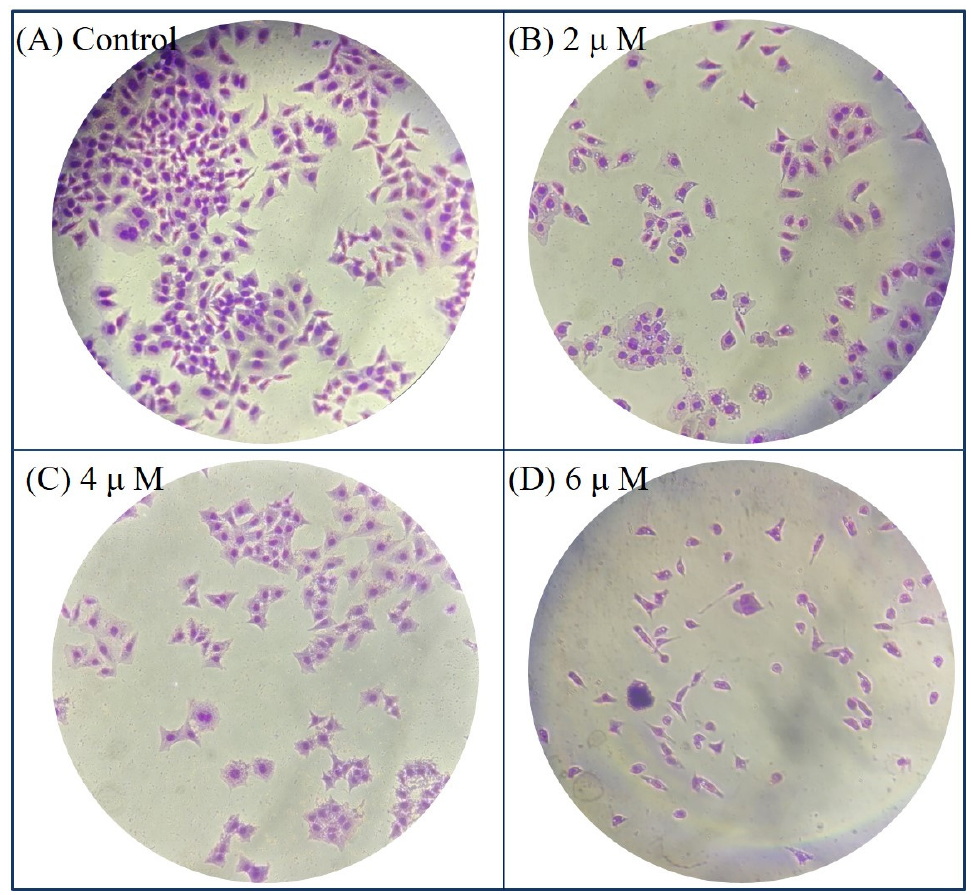
Figure 5. Morphological detection of apoptosis using Giemsa staining (200×) on A549 (human non-small-cell lung cancer) cells treated with compound 9 : ( A ) control group; ( B ) 2 µM; ( C ) 4 µM; ( D ) 6 µM. 4′,6-Diamidino-2-phenylindole (DAPI) Staining